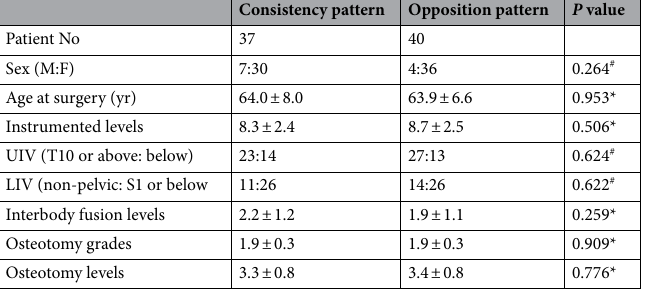
Table 1. Patient characteristics between two pattern groups. UIV upper instrumented vertebra, LIV lower instrumented vertebra. *Independent t test. # Chi-square test.